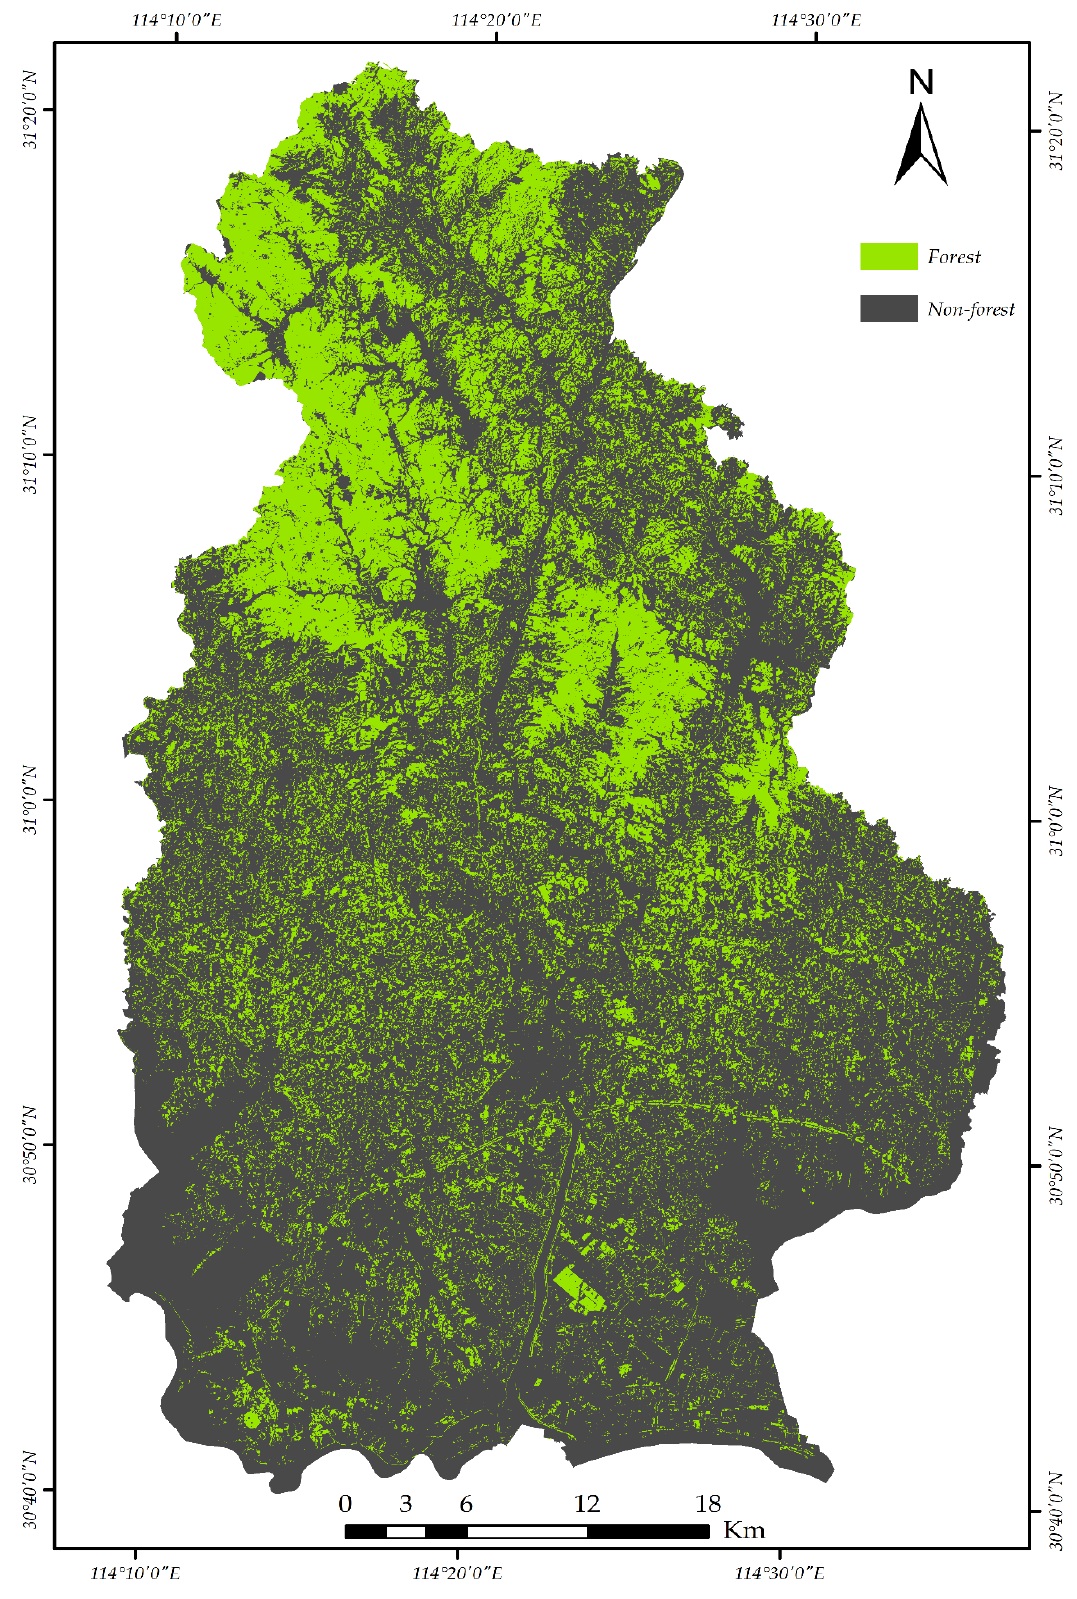
Figure 5. The final extracted forest map from the best combination of Sentinel-2A and DEM images.